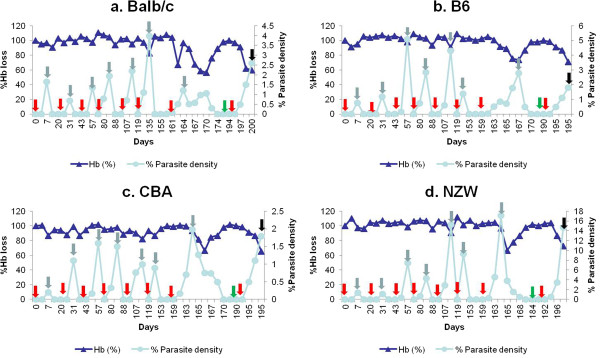
Parasitaemia and haemoglobin profile in the mice strains during the seven cycles of infection and treatment. The above data are representative data of one mouse per strain. Red arrows refer to infection with 104Plasmodium berghei ANKA; blue arrows refer to treatment with chloroquine/pyrimethamine; green arrows refer to blood harvested at recovery after two weeks rest; black arrows refer to blood harvested during infection. Recovery refers to time at which mice has been rested for two weeks after treatment with chloroquine/pyrimethamine for 6 days or until parasitaemia is zero. Upper left graph a refers to profile for Balb/c; upper right graph b refers to profile for B6; lower left graph c refers to profile for CBA and lower right graph d refers to profile for NZW.